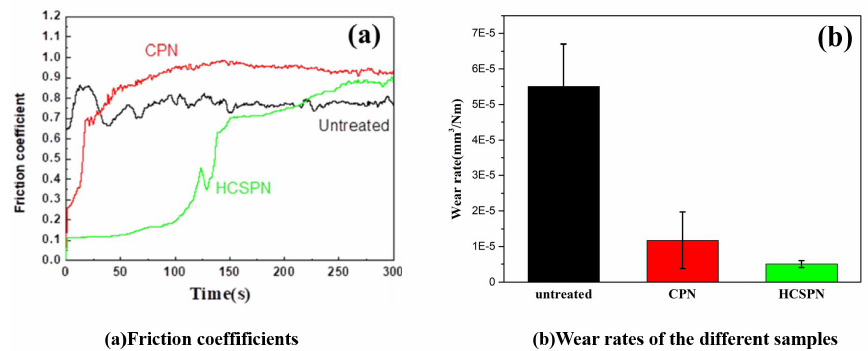
Figure 9. Friction coefficients (a) and wear rates (b) of the samples after the different treatments.